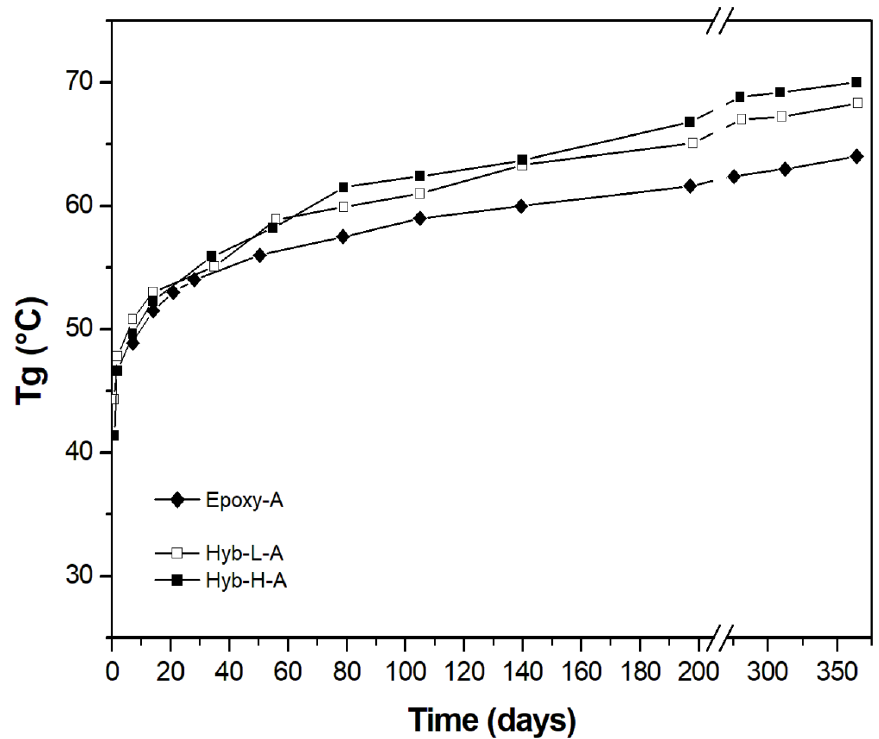
Figure 6. Temporal evolution of T g as a function of DES content for epoxy systems cured with TETA hardener.